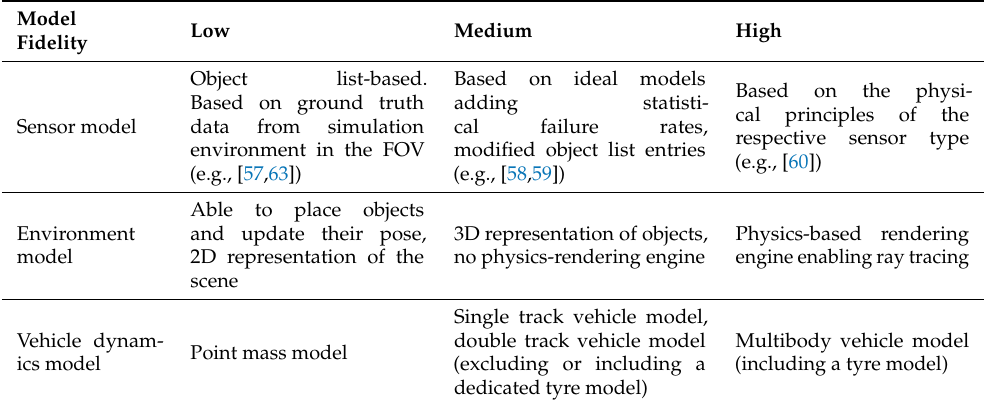
Table 3. Different model fidelities for the three relevant subsystems. Model